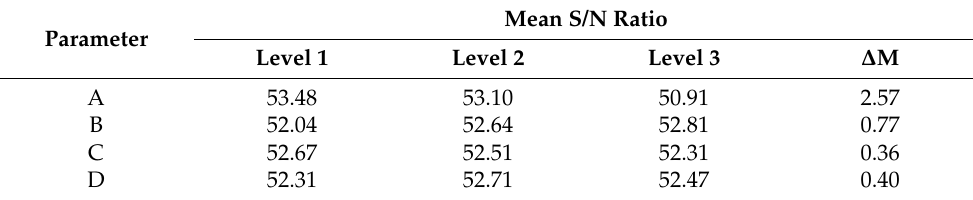
Table 10. S/N response for hardness of the